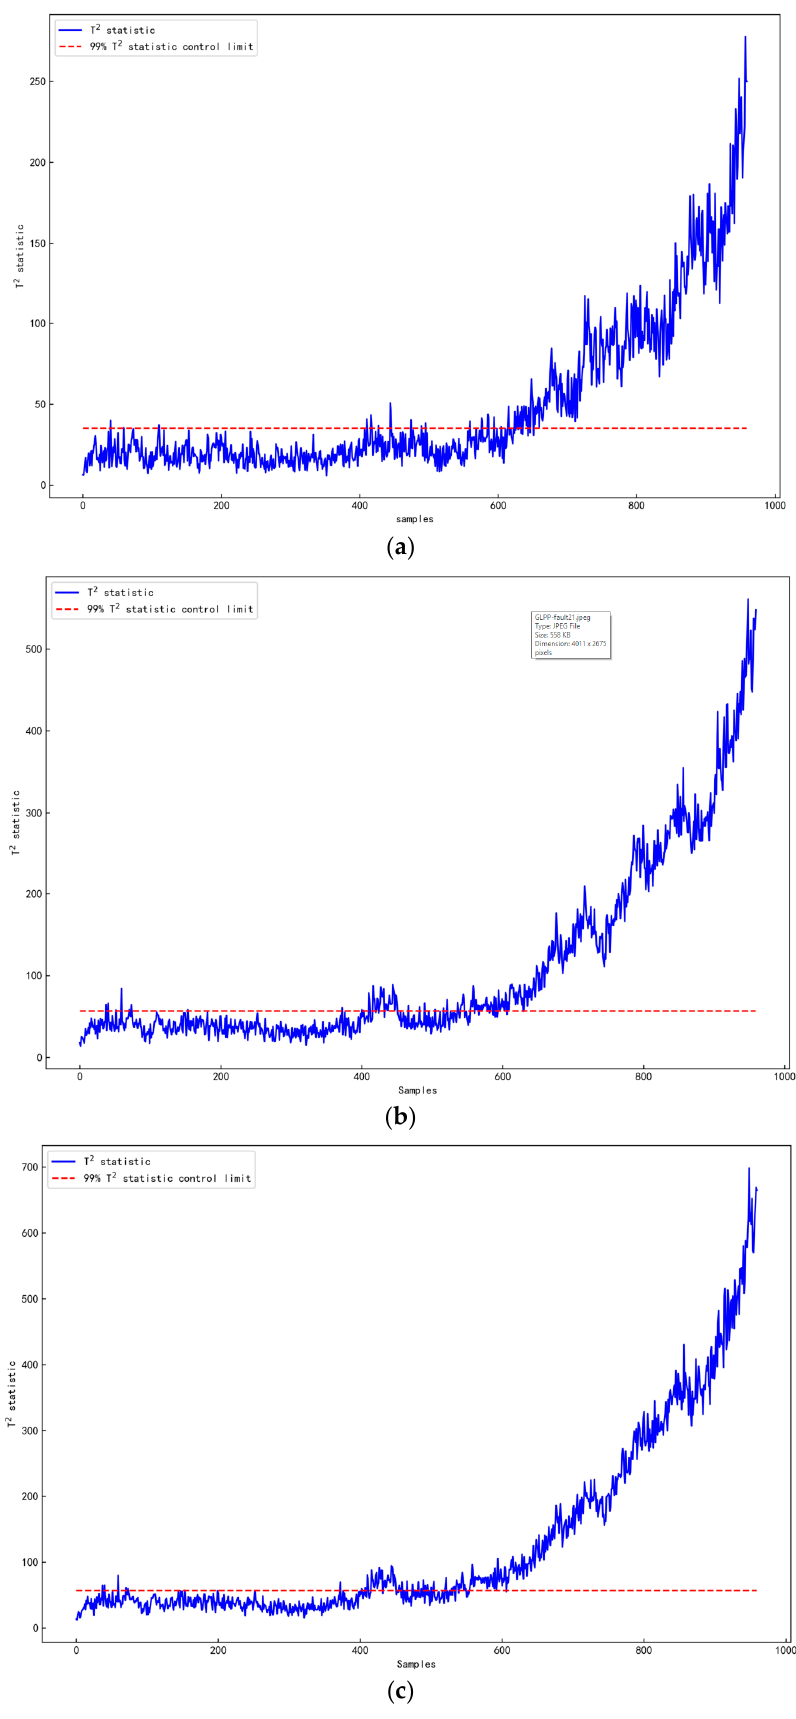
Figure 3. Detection charts of three methods for fault21: ( a ) PCA; ( b ) GLPP; ( c ) GLMDPP.